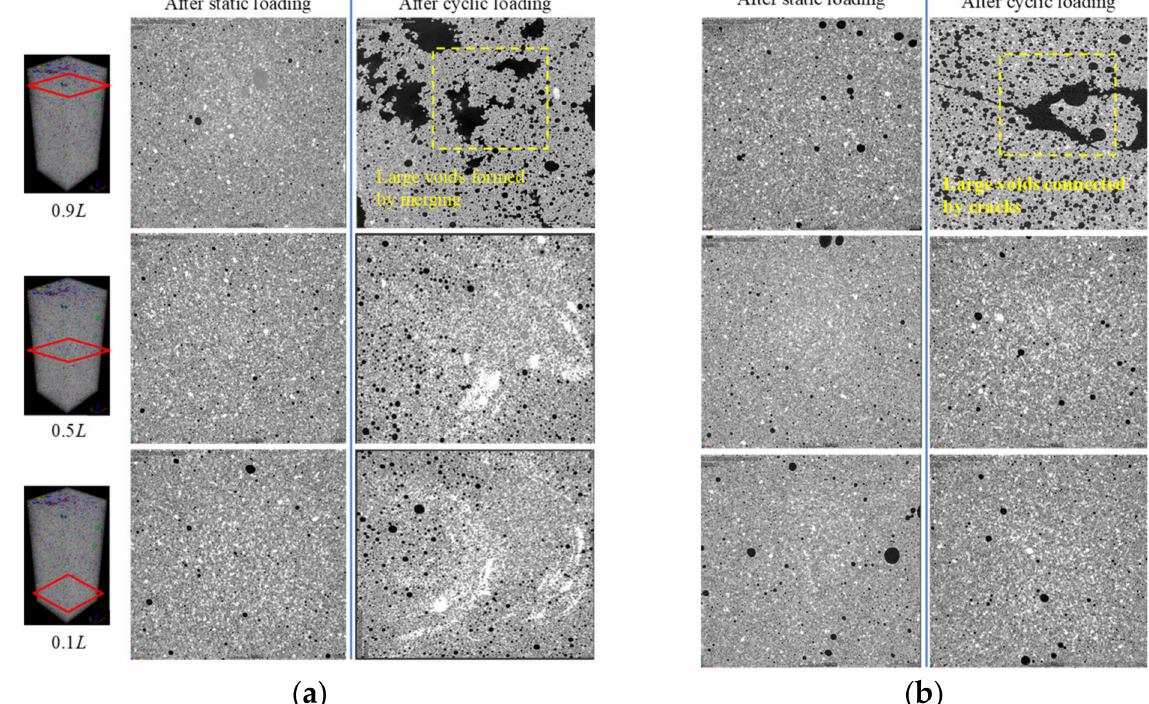
Figure 10. Comparison of cross-sectional greyscales of the FC7 specimens after static and cyclic loading tests: ( a ) R = 0.2, ( b ) R =